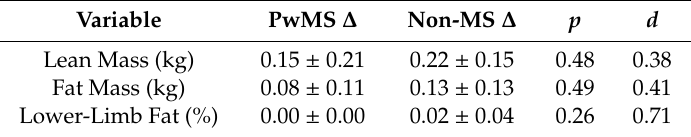
Table 2. Di ff erence between lower limbs for lean and fat mass.